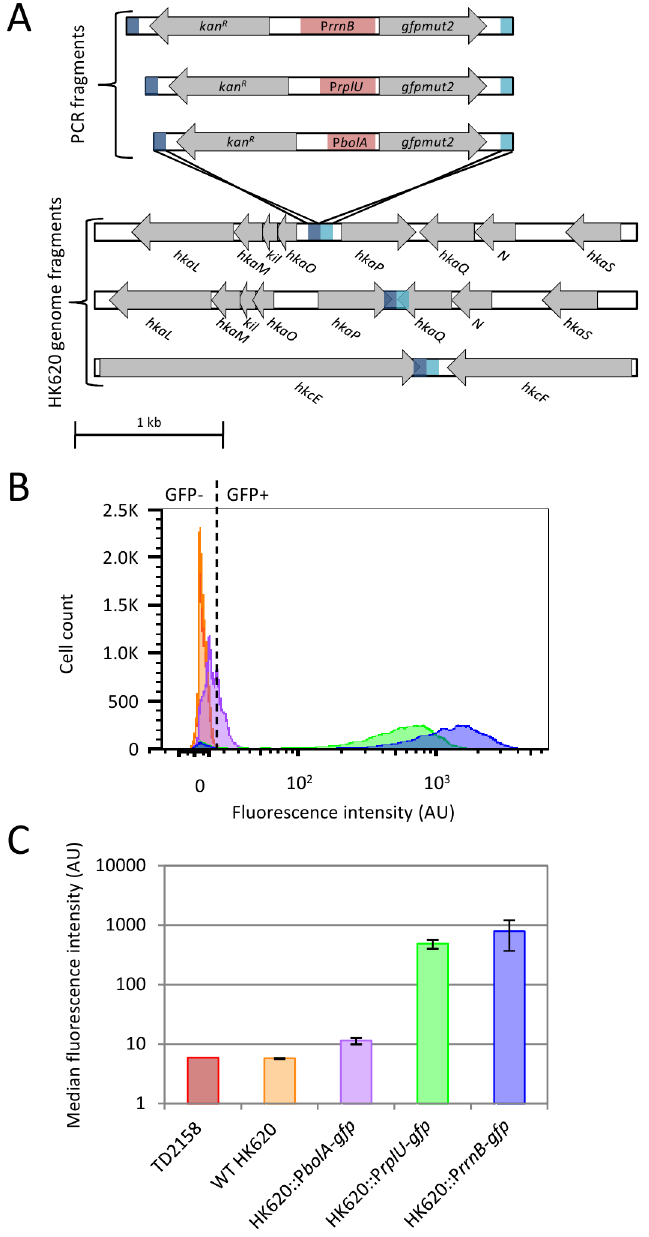
Fig 1. Characterisation of phagosensor constructs. (A) Three PCR fragments containing the gfpmut2 gene under the control of either P rrnB , P rplU or P bolA promoter (red boxes), the kanamycin resistance- cassette and 80 bp homologous to the insertion region (dark and light blue) were recombined into the hkaO / hkaP , hkaP / hkaQ or hkcE / hkcF intergenic regions on the HK620 genome by the lambda Red recombination. (B) Fluorescence intensities of infected bacterial population measured by flow cytometry. Bacteria were infected for 1 hour at 37°C. Cytometry histograms represent the number of fluorescent or non fluorescent cells gated to the bacterial population as a function of the fluorescence intensity. The dotted line represents the limit between negative fluorescence (GFP-) and positive fluorescence (GFP+) determined by the fluorescent negative control WT HK620. Color code: non infected E . coli TD2158 (red), E . coli TD2158 infected with WT HK620 (orange) or recombinant phages HK620::P bolA - gfp (purple), HK620::P rplU - gfp (green), HK620::P rrnB - gfp (blue) (C) Histograms represent the means of median fluorescence intensities obtained with triplicate samples for 3 constructs. Color code is identical to (B).